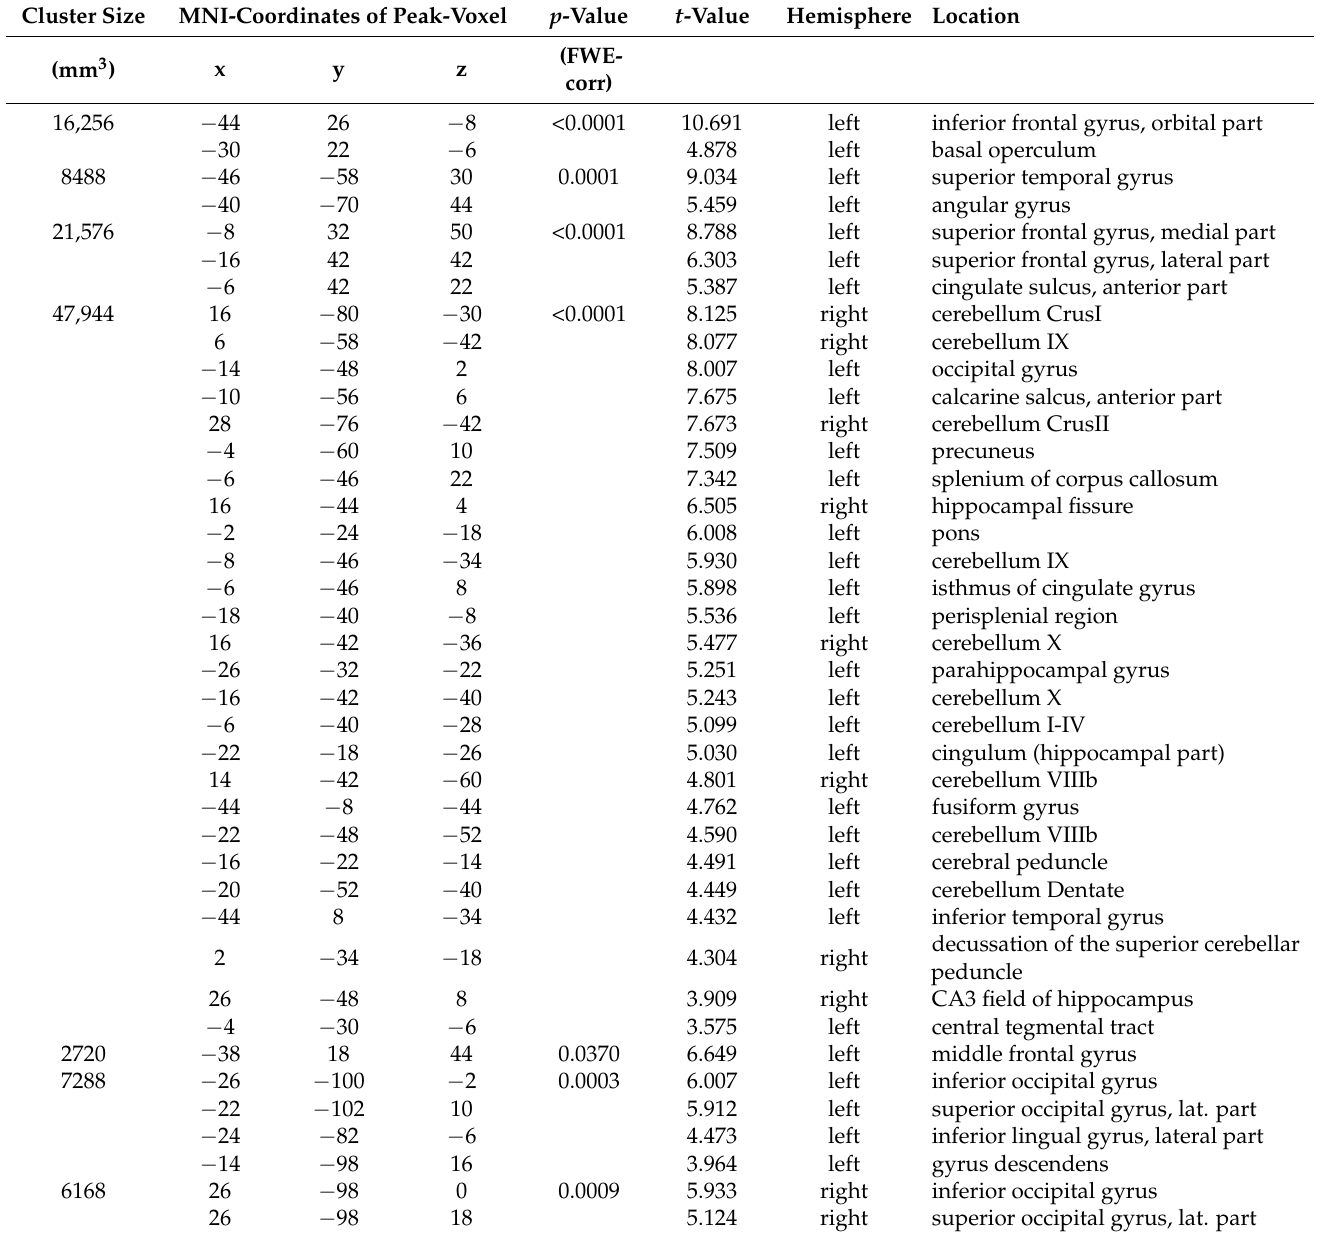
Table 2. Significant clusters of brain activity in the evaluation phase of introspection, including both preference and familiarity judgments, as contrasted with object feature identification. The locations of local maxima were defined according to Mai et al.